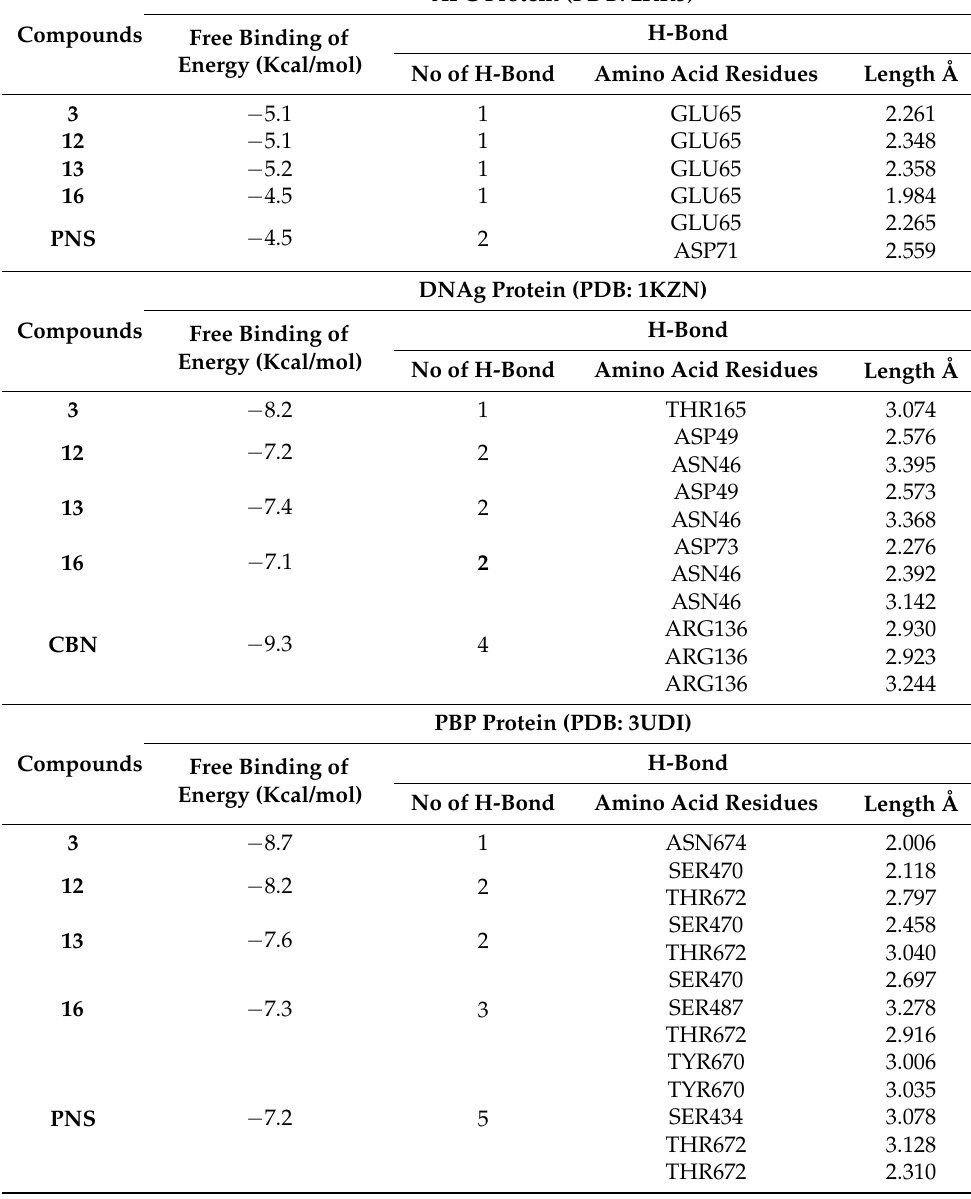
Table 3. Results of the docking study of compounds against fungal type I polyketide synthase (ACP), DNA gyrase, and Baumannii penicillin-binding protein (PBP) in comparison to the corresponding co-crystallized